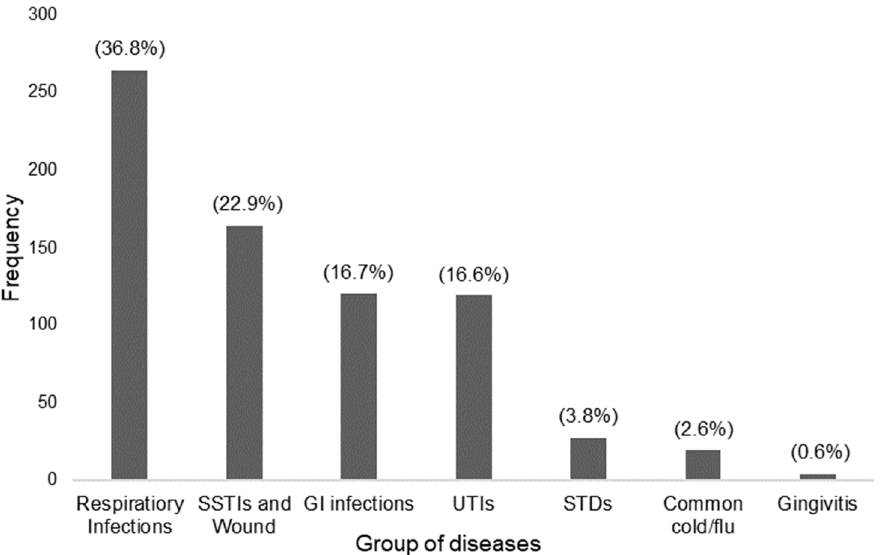
Figure 1. Commonly encountered infections in community pharmacies in Thailand. Respiratory infections included lower respiratory infections, upper respiratory infections, bronchitis, nasopharyngitis, otitis media, pharyngitis, rhinitis, sinusitis, sore throat, and tonsillitis. SSTIs (Skin and Soft Tissue Infections) and wounds included abscess, acne, bacterial skin infection, cellulitis, conjunctivitis, hordeolum, herpes simplex, impetigo, and tinea. UTIs (Urinary Tract Infections) included cystitis. GI (Gastro-Intestinal) infections included diarrhoea. STDs (Sexually Transmitted Diseases) included candidiasis, chlamydia, vaginitis, and gonorrhoea. Community pharmacists provided a total of 742 responses when asked about the most commonly dispensed antimicrobials in their practice setting. Amoxicillin, Amoxicillin/Clavulanic acid, and Ampicillin, grouped as aminopenicillins, were the most commonly dispensed antibiotics (39.8%), Followed by Fluoroquinolone (25.1%) and Penicillinase-resistance penicillin (17%). Findings are shown in Figure 2.